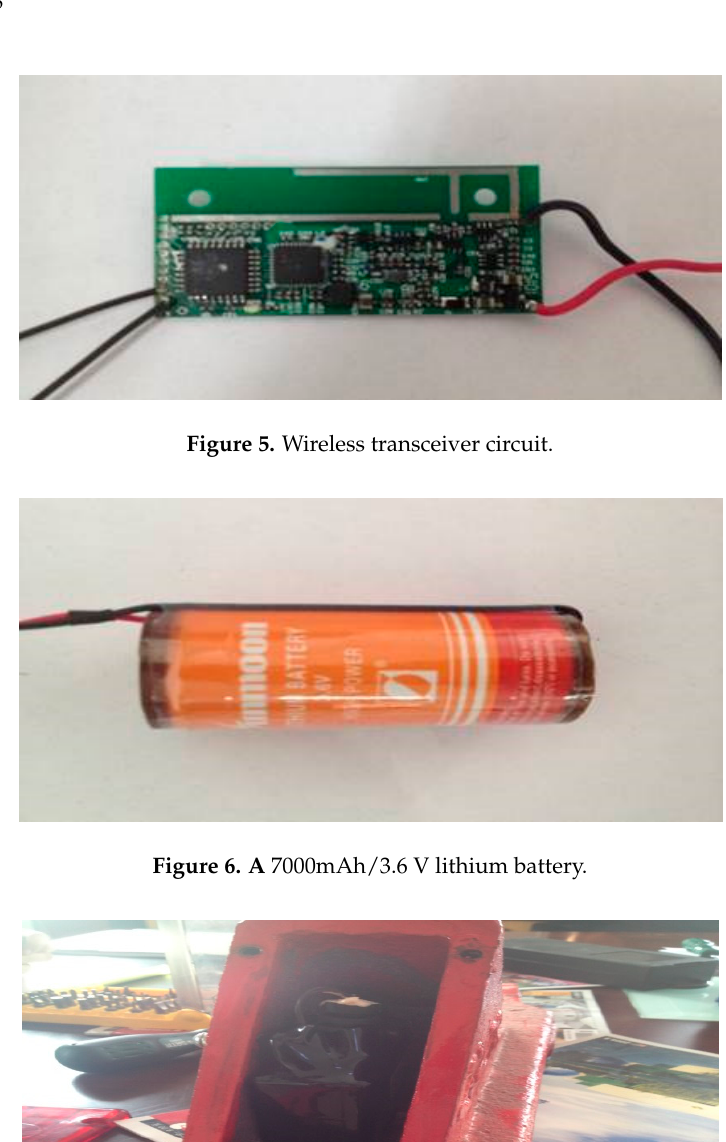
Figure 4. On-track inspection travel switch.